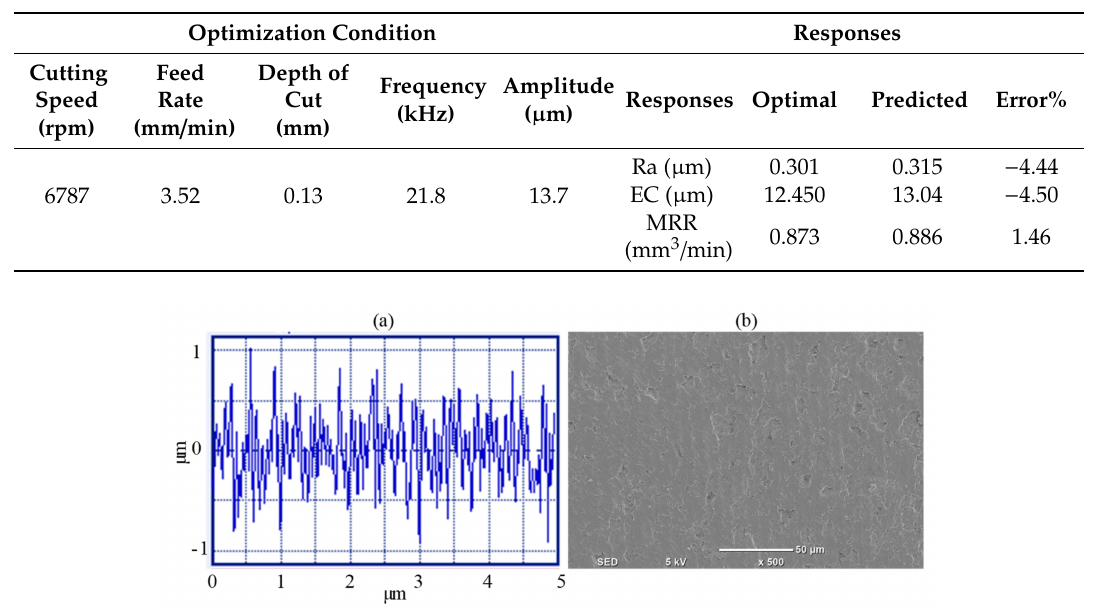
Figure 16. ( a ) The 2D surface profile of the machined pocket at the optimal RUM parameters, ( b ) surface morphology of the machined pocket at the optimal RUM